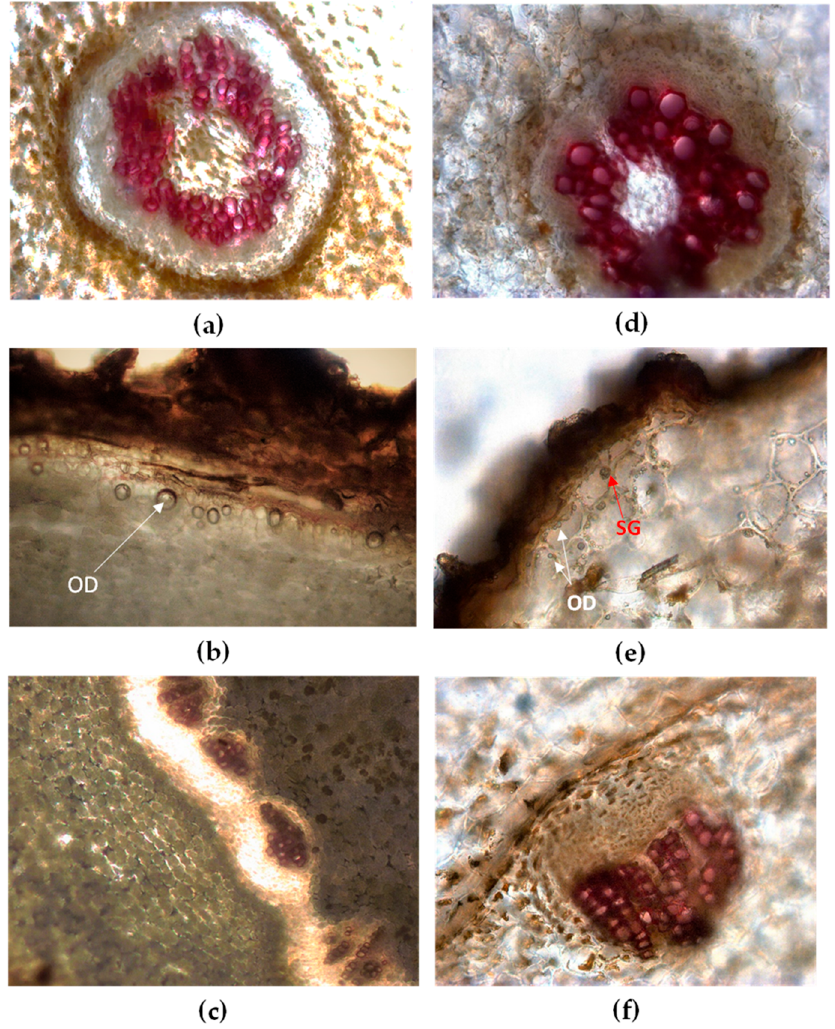
Figure 2. Light microscopy view of root / rhizome transversal sections (TS) of Vo ( a – c ) and Vj ( d – f ) stained with phloroglucinol-HCl. Vo: ( a ) cortex and stele in older roots; ( b ) under the rhizome cork the outermost layers of parenchymatous cortex contain oil droplets (OD, arrow); ( c ) collateral vascular bundles circularly arranged in the rhizome. Vj: ( d ) cortex and stele in older roots; ( e ) starch grains (SG, arrow) and oil droplets (OD, arrows) are visible within parenchymatous cortex; ( f ) magnification of a singular collateral vascular bundle in the rhizome.